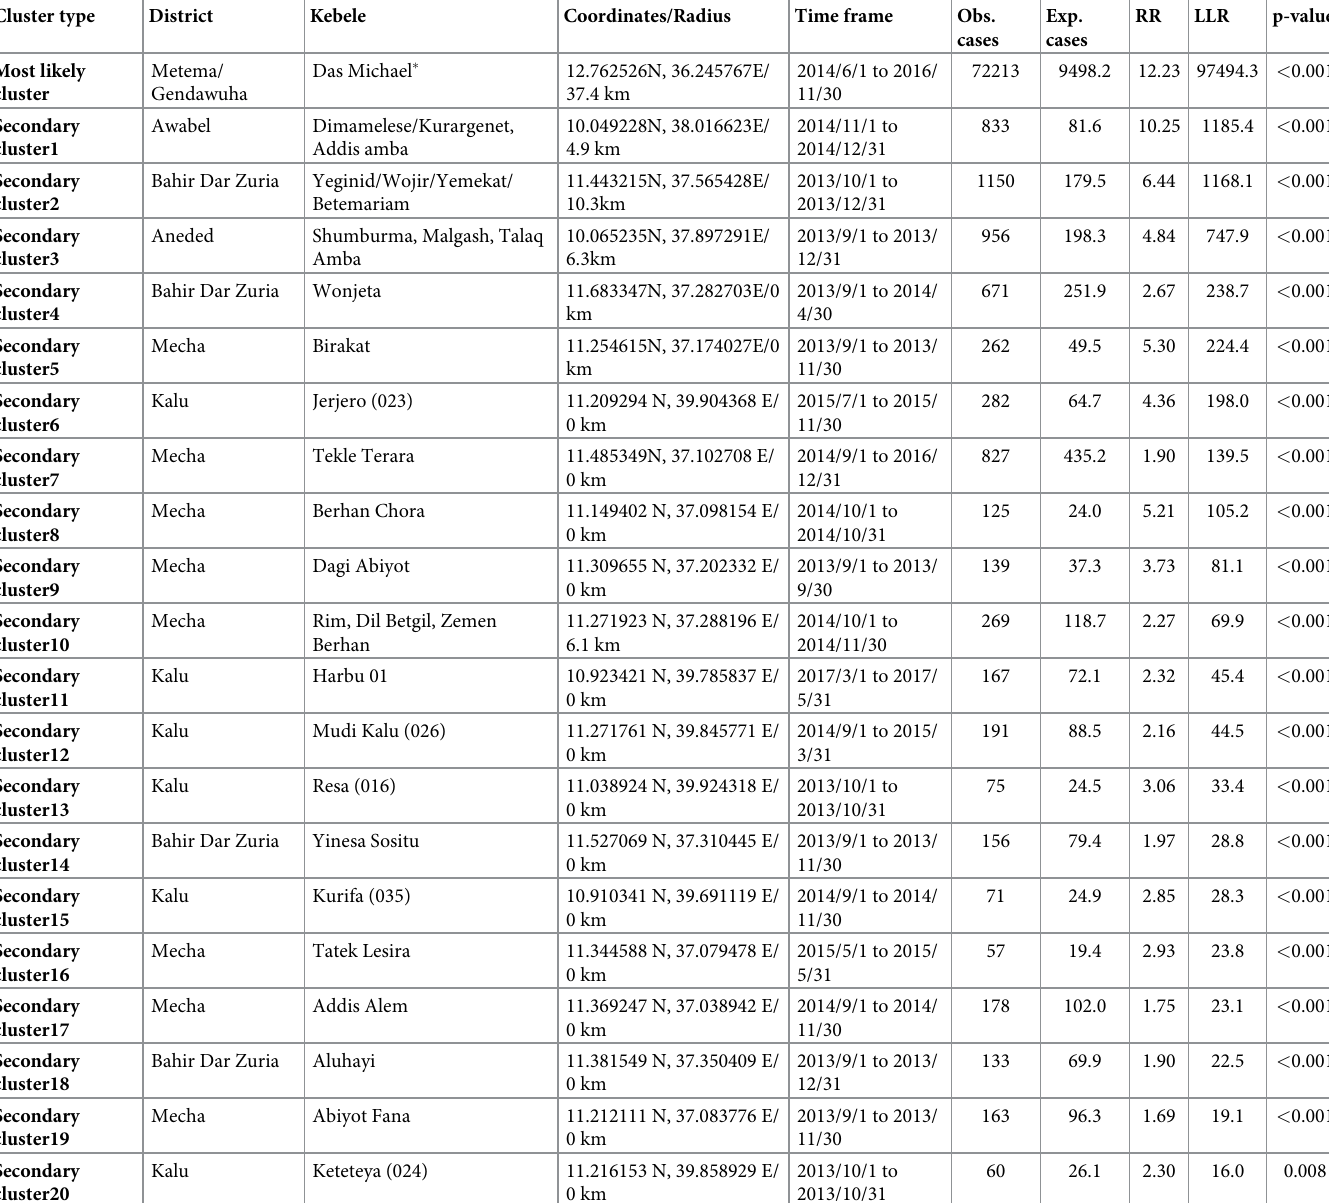
Table 6. Spatiotemporal clusters of malaria cases in the study areas, between 2013/09 to 2018/. Cluster type District